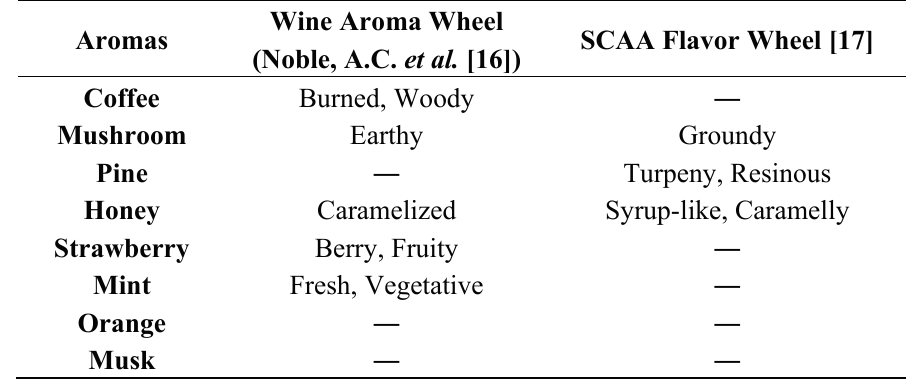
Table 3. Aromas recognized by the FF-2A electronic nose and their attribution in the wine and the coffee